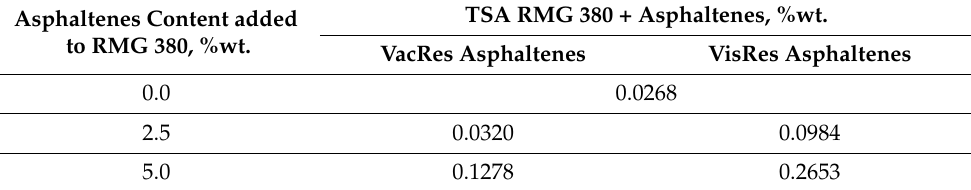
Table 5. TSA results for RMG 380 with VacRes and VisRes